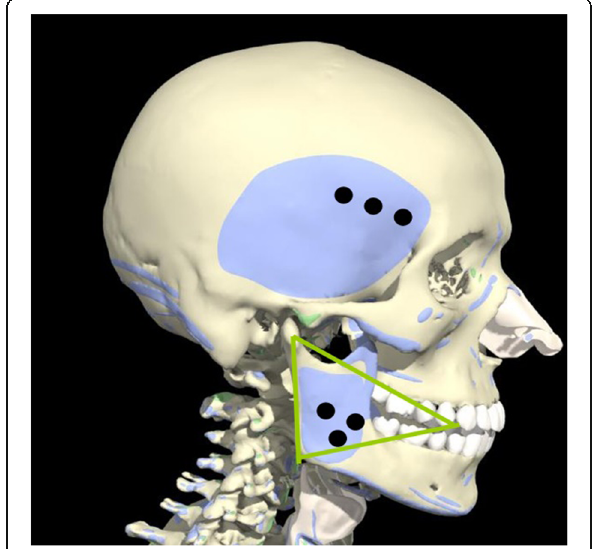
Fig. 10 Areas colored with blue represent temporal and masseter muscles, black point represent injection point, and approximately 10 BU is injected to each injection point. Triangular area colored with yellowish green represent the landmark line of masseter muscle hypertrophy